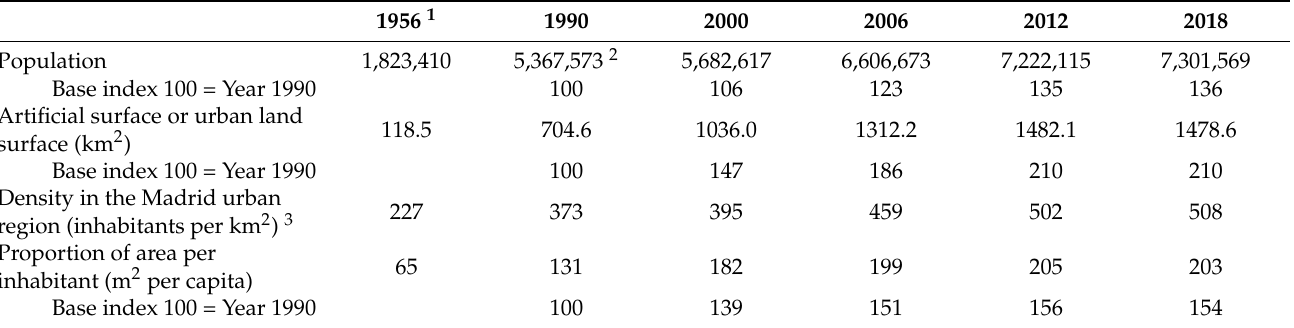
Table 2. Evolution of the population and artificial surface of the Madrid urban region in selected years. Source: National Center for Geographic Information and National Institute of Statistics of